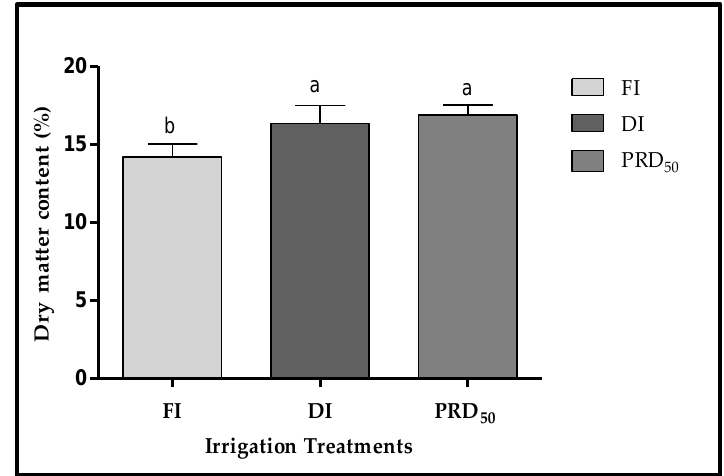
Figure 4. Fruit dry matter (±SD) of Flordastar peaches grown under FI, DI and PRD 50 irrigation treatments, expressed in (%). Different letters refer to significant differences tested by Duncan’s multiple range test ( p < 0.05).